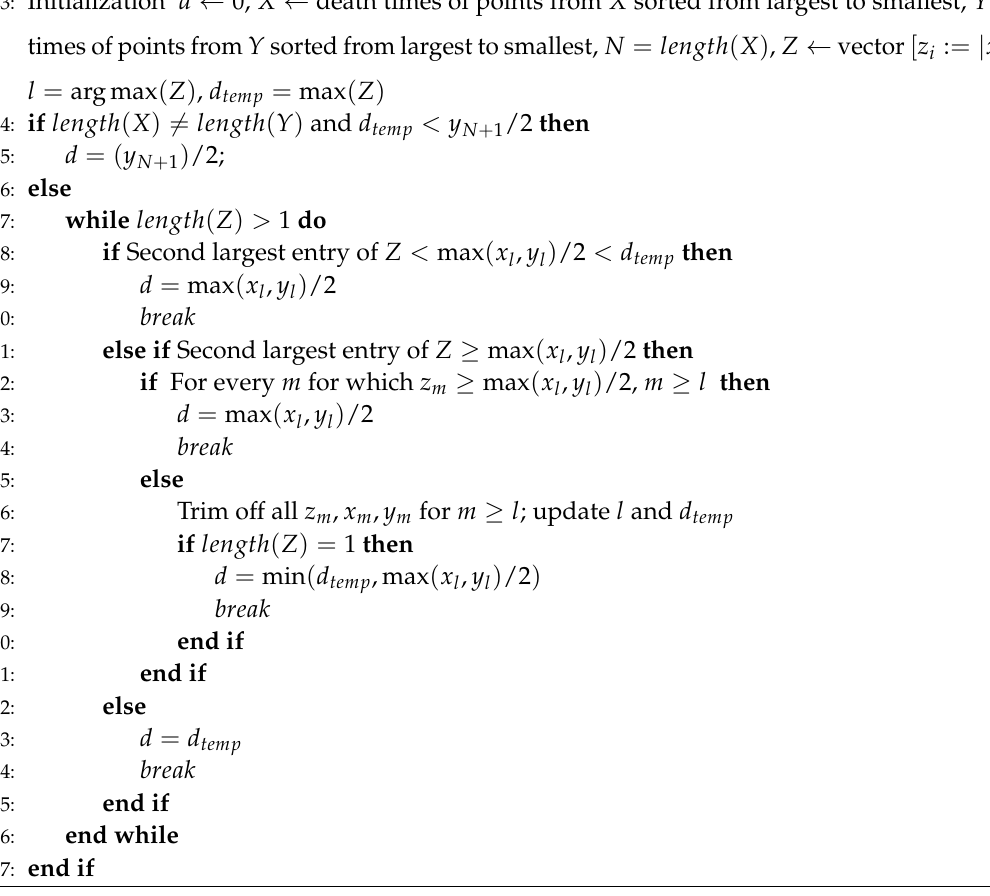
Algorithm 1 L UMÁWIG algorithm for computing 0-dimensional bottleneck distance between two persistence